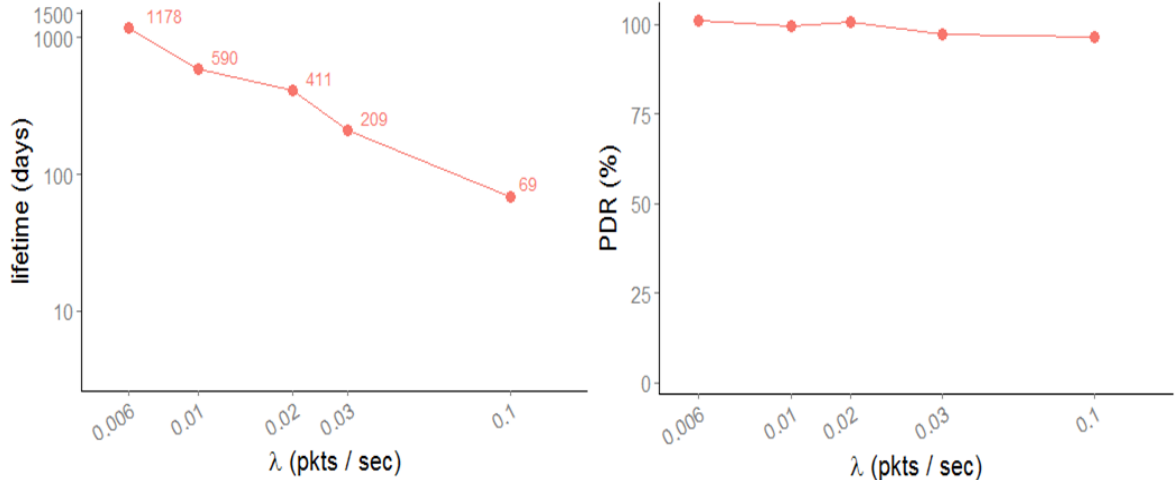
Figure 13. Lifetime in days ( left ) and PDR ( right ) of node